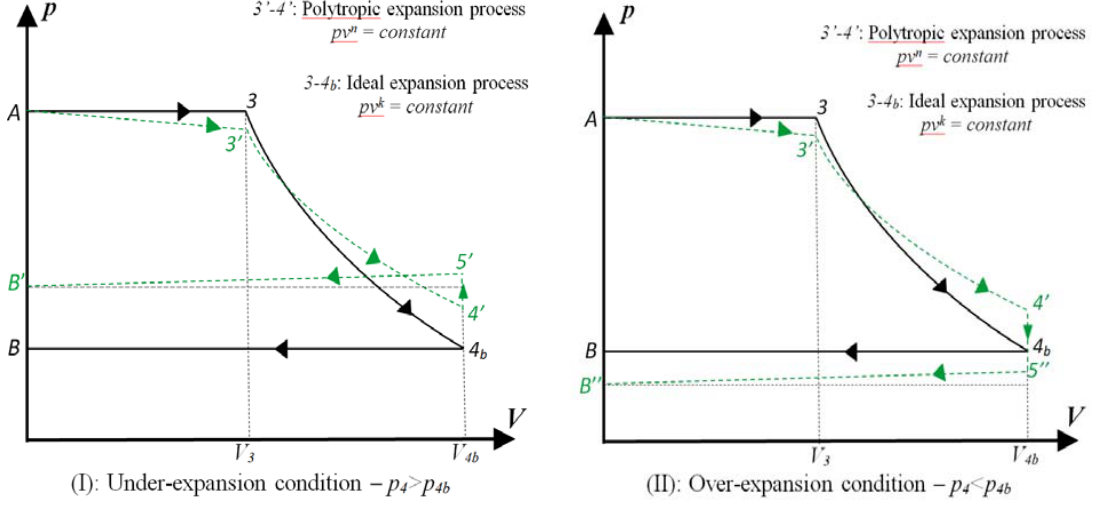
Figure 2. ( I ): Real expansion phase with a “blowdown effect” during the polytropic under ‐ expansion process (patch in green line: A ‐ 3’ ‐ 4’ ‐ 5’ ‐ B’ ) and isentropic expansion process (patch in black line: A ‐ 3 ‐ 4b ‐ B ).( II ): Real expansion phase with a “blowback effect” during the polytropic over ‐ expansion process (patch in green line: A ‐ 3’ ‐ 4’ ‐ 5’’ ‐ B’’ ) and isentropic expansion process (patch in black line: A ‐ 3 ‐ 4b ‐ B ).